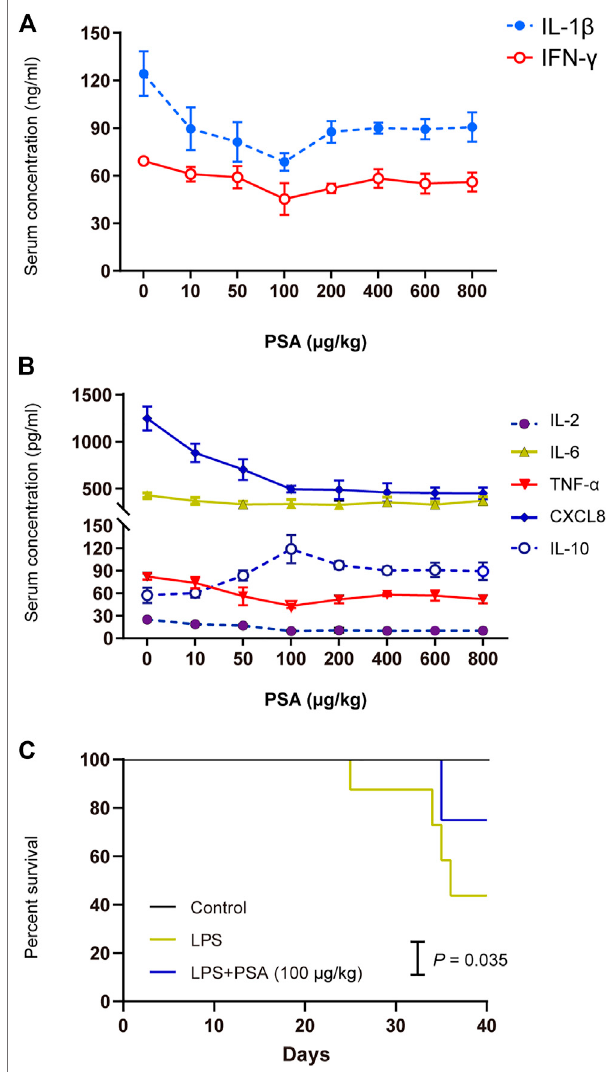
FIGURE 3 | Concentration screening over the effect of PSA on animal models. (A,B) Screening assay was performed at eight PSA concentrations (0, 10, 50, 100, 200,400, 600 and 800 μ g/kg) in animals ( n (cid:1) 5, respectively). Optimum PSA concentration selection based on the levels of proin fl ammatory cytokines. (C) Kaplan-Meier survival curve analysis with PSA (100 μ